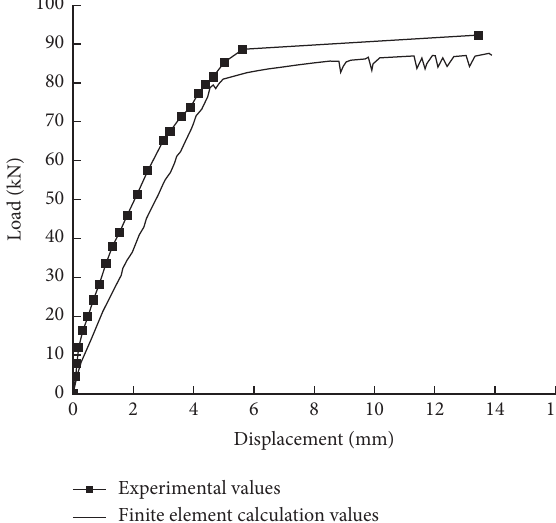
Figure 11: Load-deflection curve of test beam